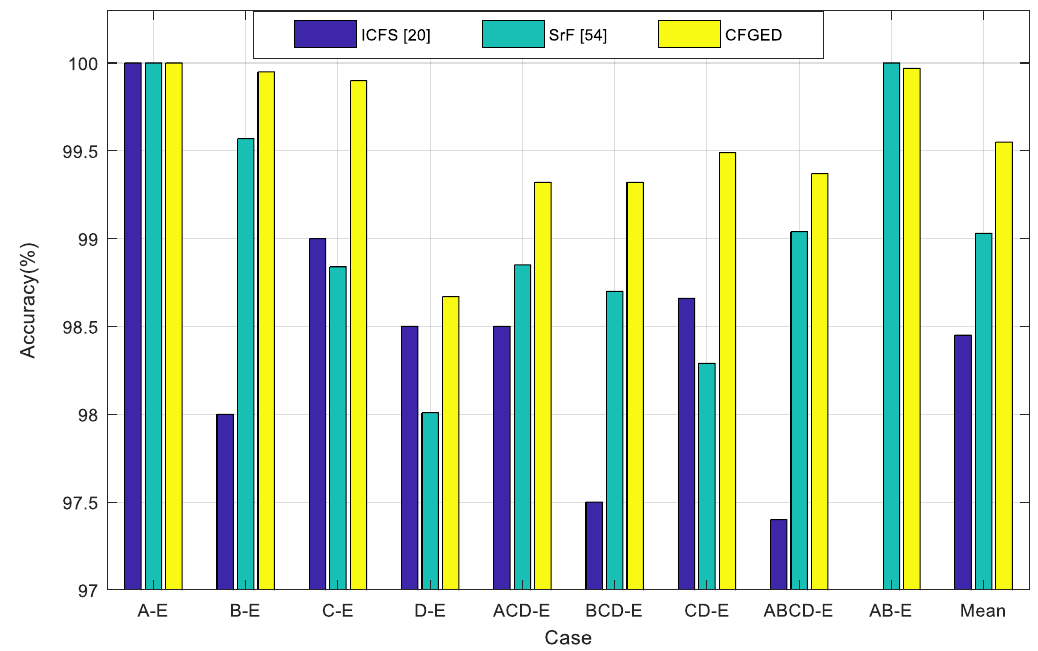
Figure 6. Comparison of the performance of the proposed combined features with graph eigen decomposition (CFGED) method with improved correlation-based feature selection (ICFS) [20] and previous work on spike-related features (SrF) [54].